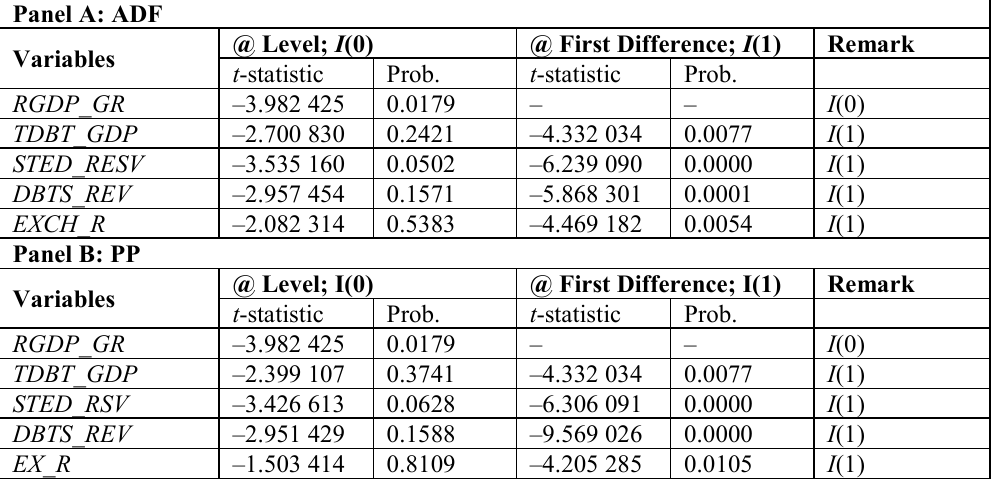
Table 2. Unit Root Test Results (The authors’ computation,